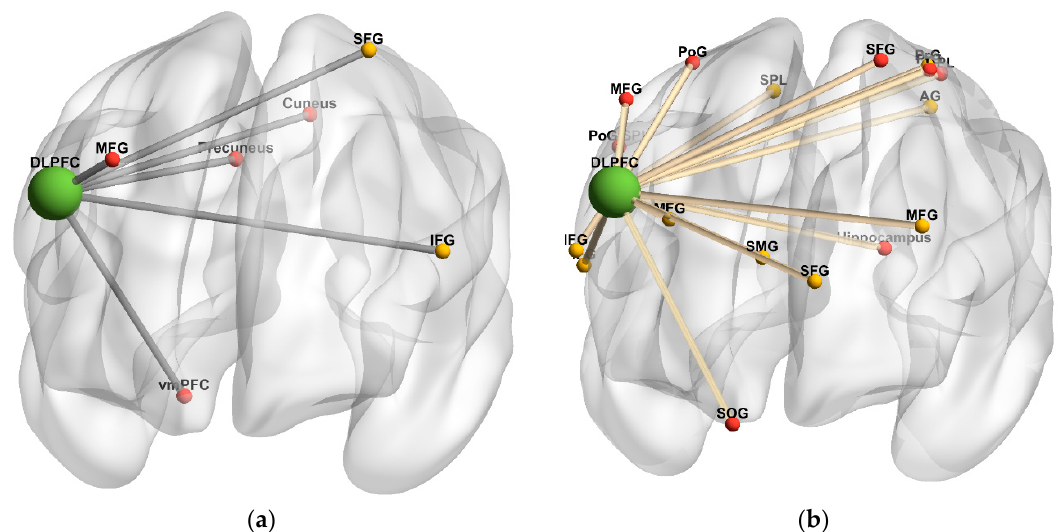
Figure 4. Dorsolateral prefrontal cortex connectivity 3-dimensional rendering. ( a ) Task-independent, fatigue-related connectivity in the healthy control group; ( b ) Task-independent, fatigue-related connectivity in the multiple sclerosis group. The seed is denoted by green spheres; regions with increased connectivity to the seed in the 2-back condition are denoted by yellow spheres, and regions with increased connectivity to the seed in the 0-back condition are denoted by red spheres. Cerebellar regions were omitted. Anterior orientation is in the front of the figure; right hemisphere is on the left side, and left hemisphere is on the right side. Abbreviations: SFG, superior frontal gyrus. MFG, middle frontal gyrus. IFG, inferior frontal gyrus. vmPFC, ventromedial prefrontal cortex. SMG, superior medial gyrus. PrG, precentral gyrus. PoG, postcentral gyrus. SOG, superior orbital gyrus. SPL, superior parietal lobule. AG, angular gyrus.